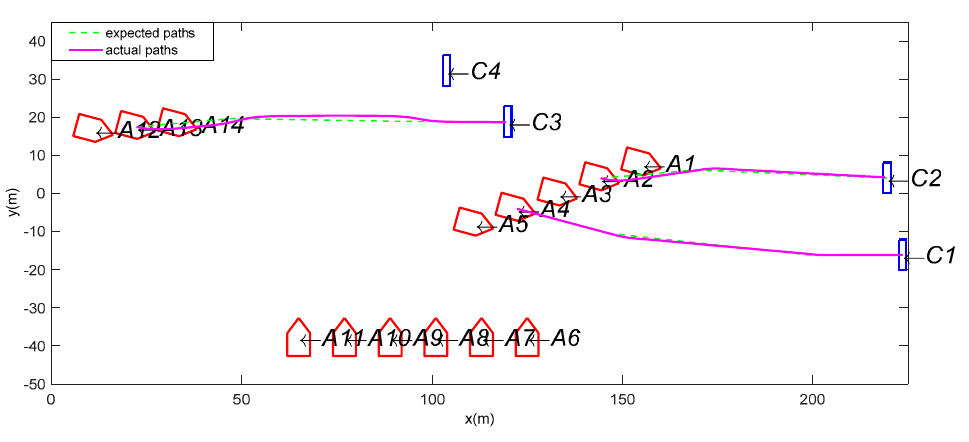
Figure 9. The taxi paths of A 1 , A 5 and A 14 .